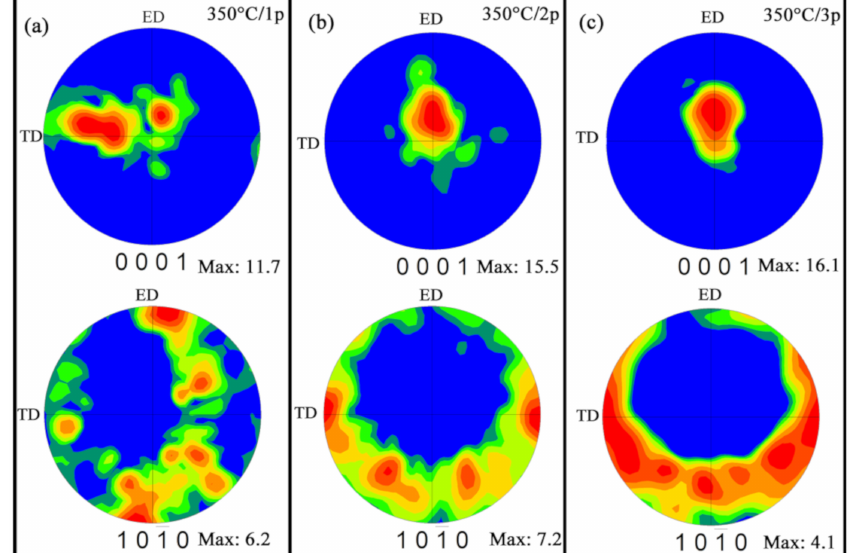
Figure 9. The pole figures of samples processed by CEE-AEC measured by EBSD analysis: ( a ) 1 pass, ( b ) 2 passes, and ( c ) 3 passes.